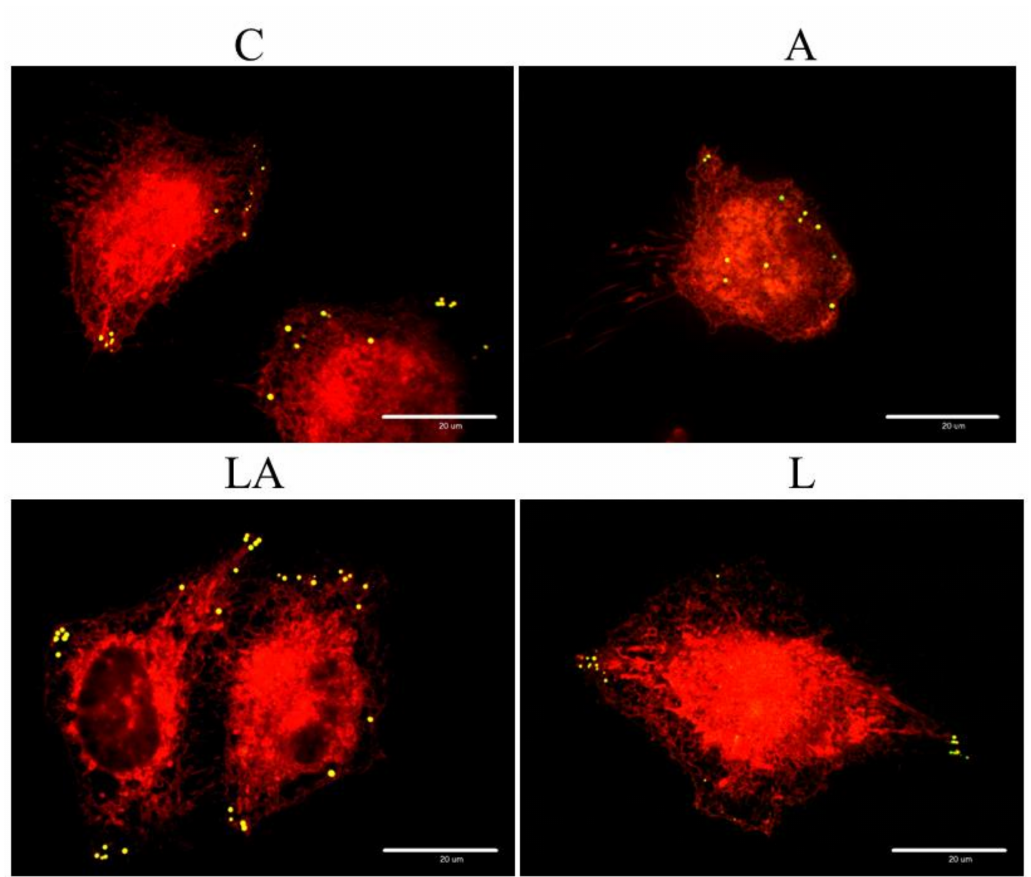
Figure A6. Representative images of HeLa cells stained with Nile red. HeLa cells were treated with the experimental media for 72 h, stained with Nile red, and inspected with confocal microscopy. Yellow fluorescence signal (488/525 nm) corresponds to droplets of neutral lipids and red signal (560/610 nm) corresponds to phospholipid membranes. C, control; A, acidosis; LA, lactic acidosis; L, high lactate.